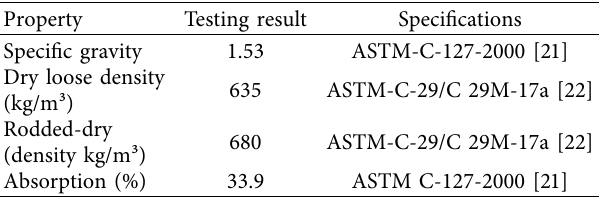
Table 5: Physical characteristics of porcelinite coarse-aggregate.